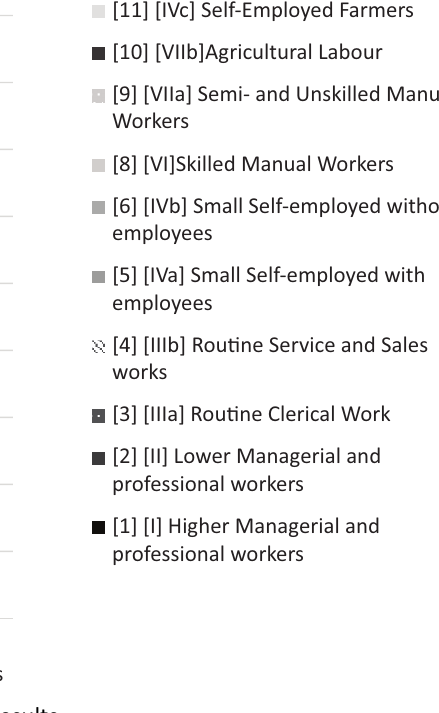
Figure 3. EGP by cluster. Source: SOEP (2019, survey year 2015), weighted